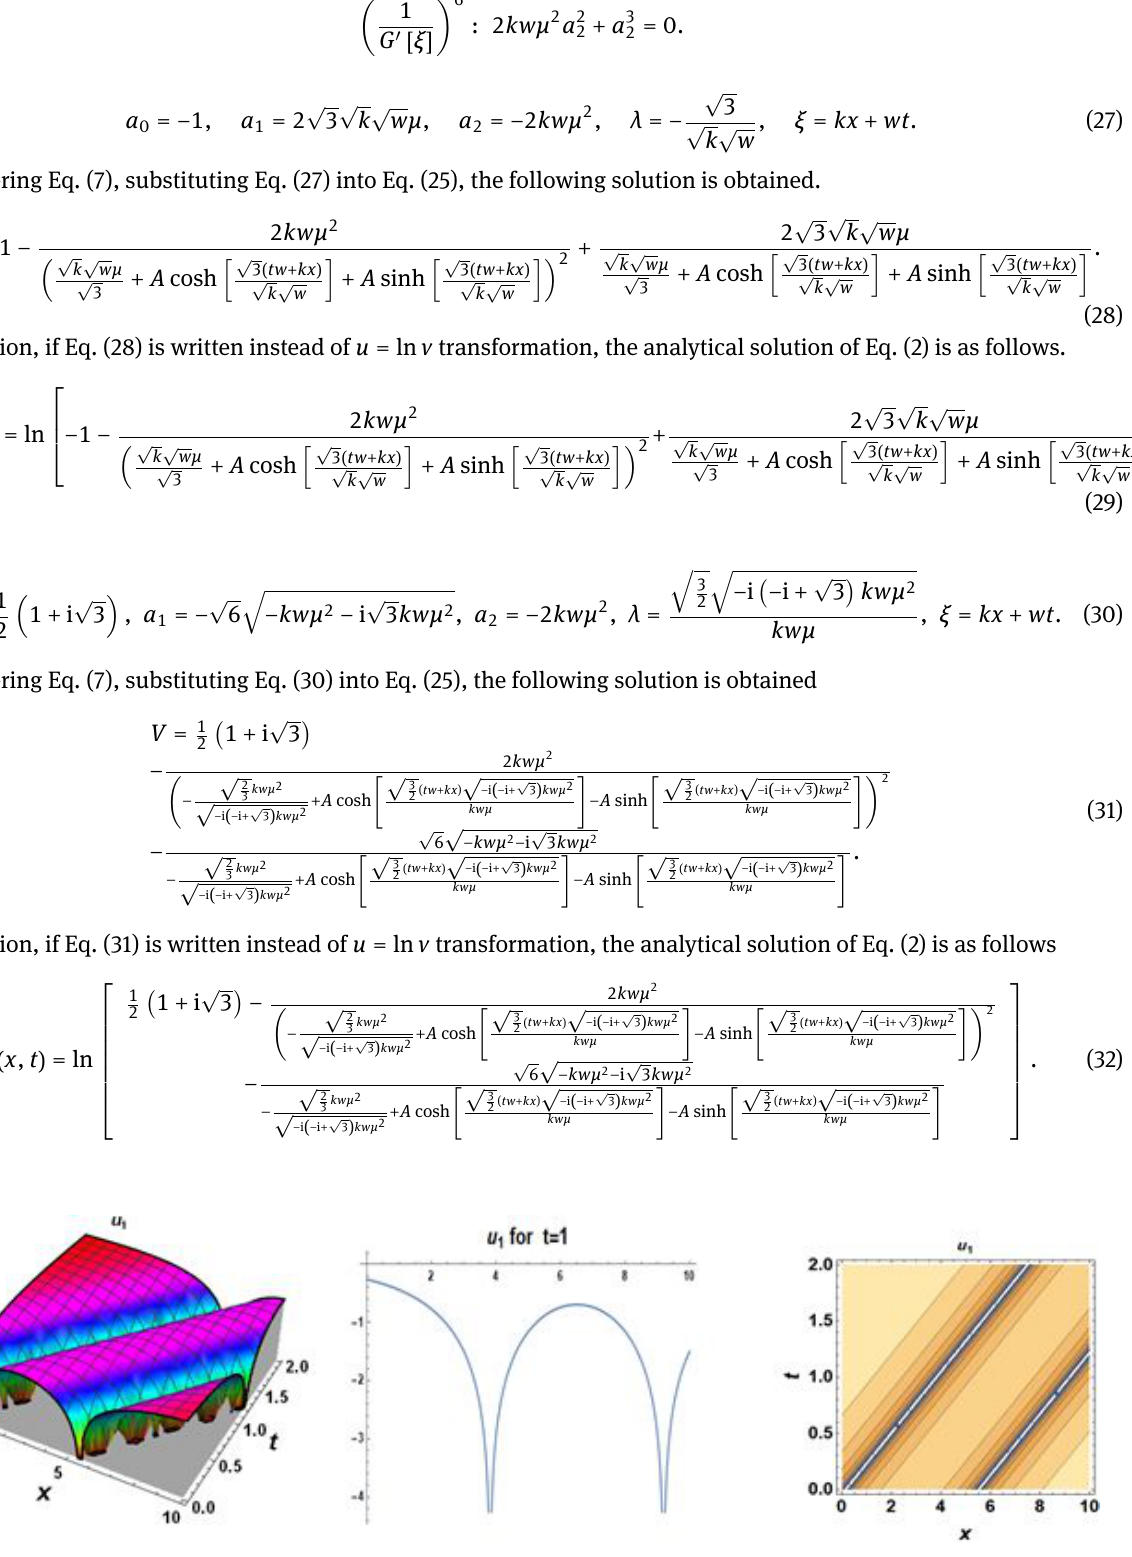
Figure 1: 3D,2D and contour graphics for A = 1, µ = −4, λ = 1, w = 1.8 values of Eq.